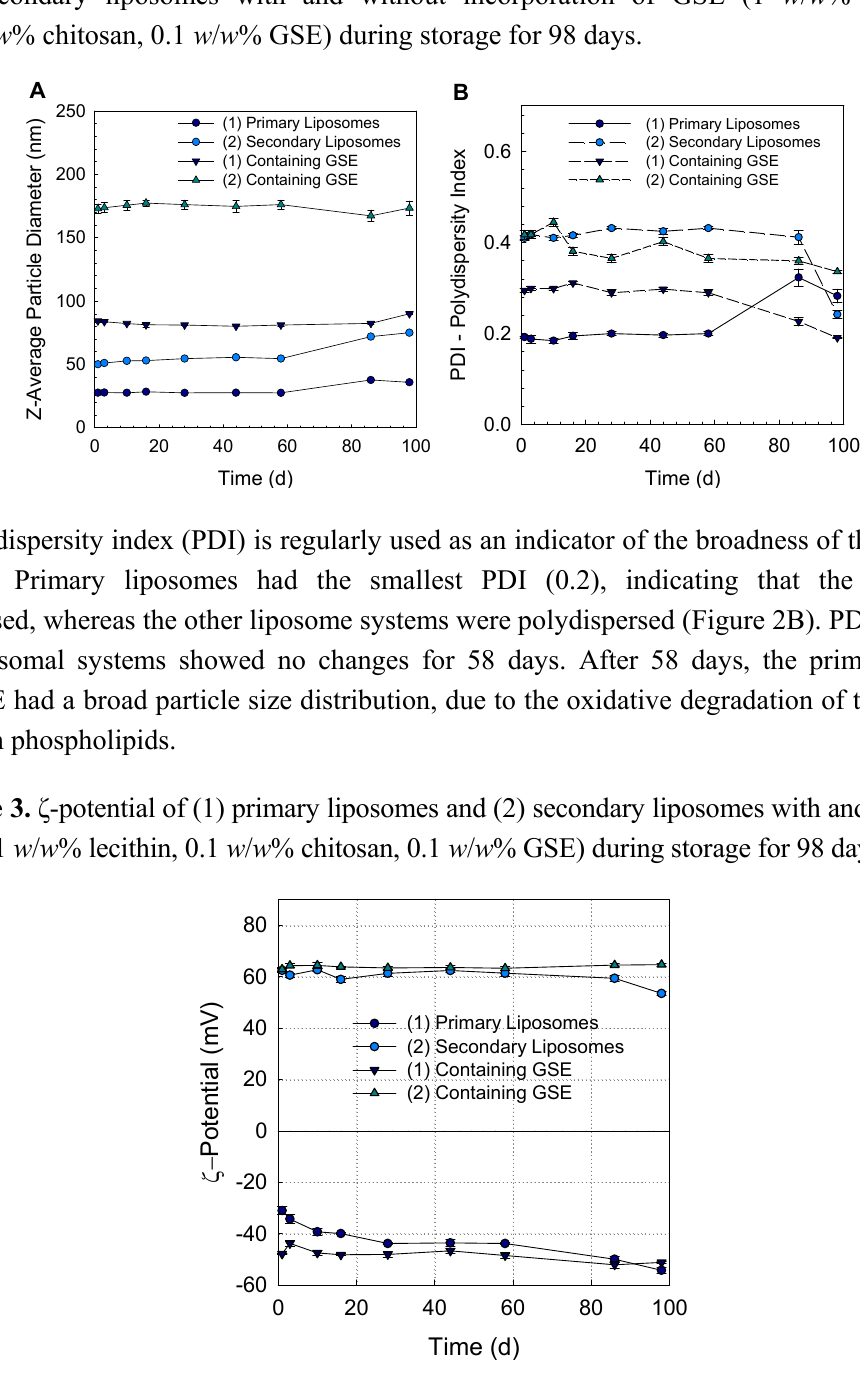
Figure 2. ( A ) Z-average diameter and ( B ) polydispersity index (PDI) of (1) primary and (2) secondary liposomes with and without incorporation of GSE (1 w / w % lecithin,